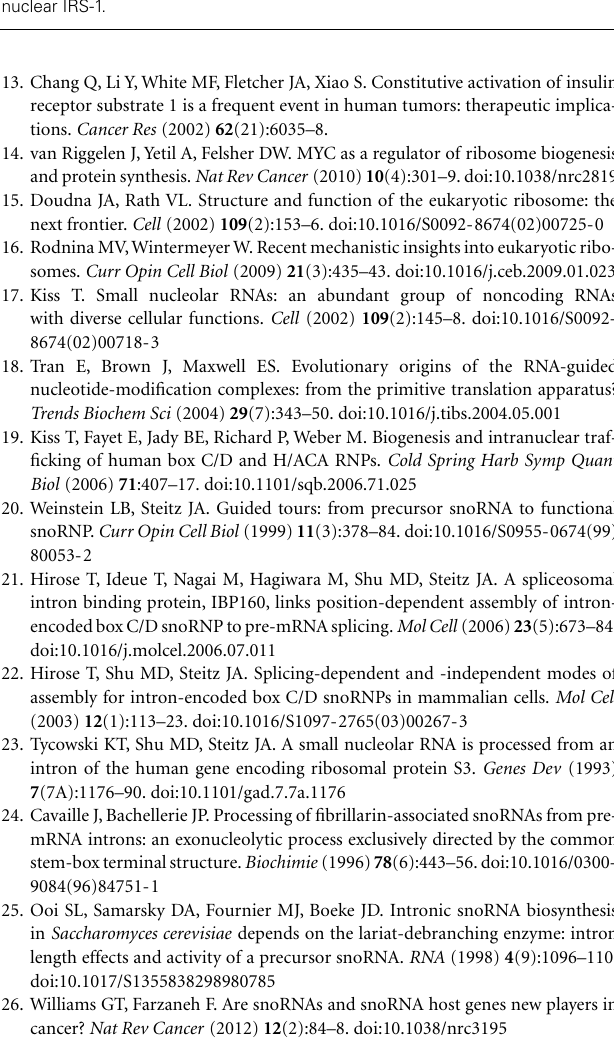
FIGURE 4 |A working hypothesis of IRS-mediated control of protein synthesis . Following IGF stimulation, intracellular signaling through IRS activates downstream PI3K–mTOR signaling pathway, which is well known to promote translation of mRNAs. Up-regulation of protein synthesis is supported by ribosome maturation, which is